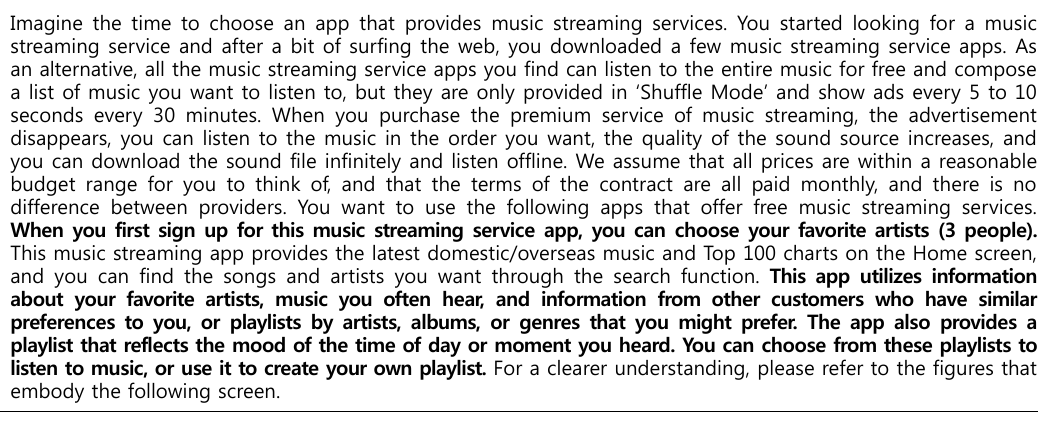
<Figure 5> Scenario 1: Before